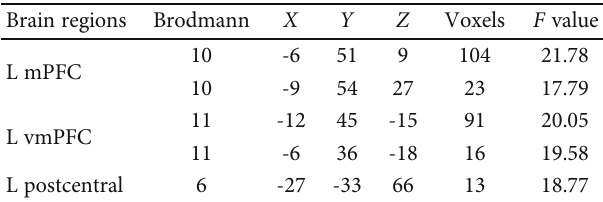
R putamen, r = 0 : 35 and p = 0 : 04 ; R paracentral lobule-R STG, r = 0 : 41 and p = 0 : 02 (S-Figure 2BCD). However, only